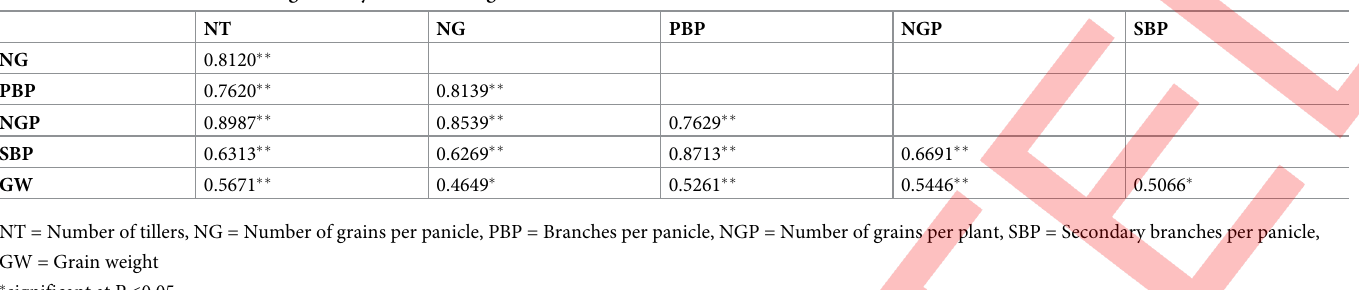
Table 2. Pearson correlation among the six yield attributing traits.